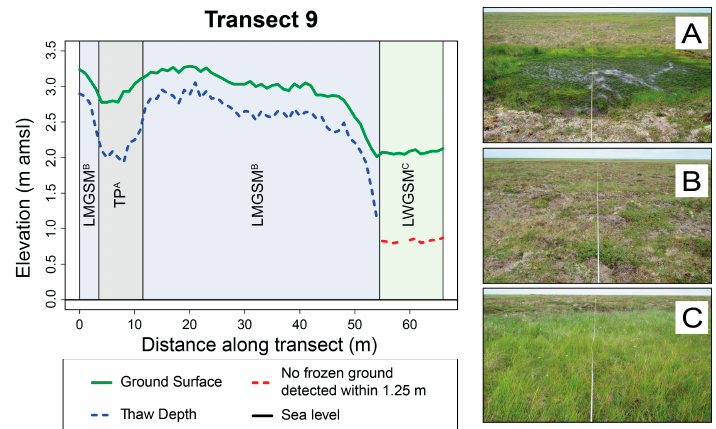
Figure 7. Elevation profile of transect 9 depicting observed ecotypes: ( A ) Thaw Pit (TP); ( B ) Lowland Moist Graminoid Shrub Meadow (LMGSM); and ( C ) Lowland Wet Graminoid-Shrub Meadow (LWGSM); surface elevation (solid green line); top of frost (dashed blue line); and areas where no frost was encountered in the top 1.25 m (dashed red line).